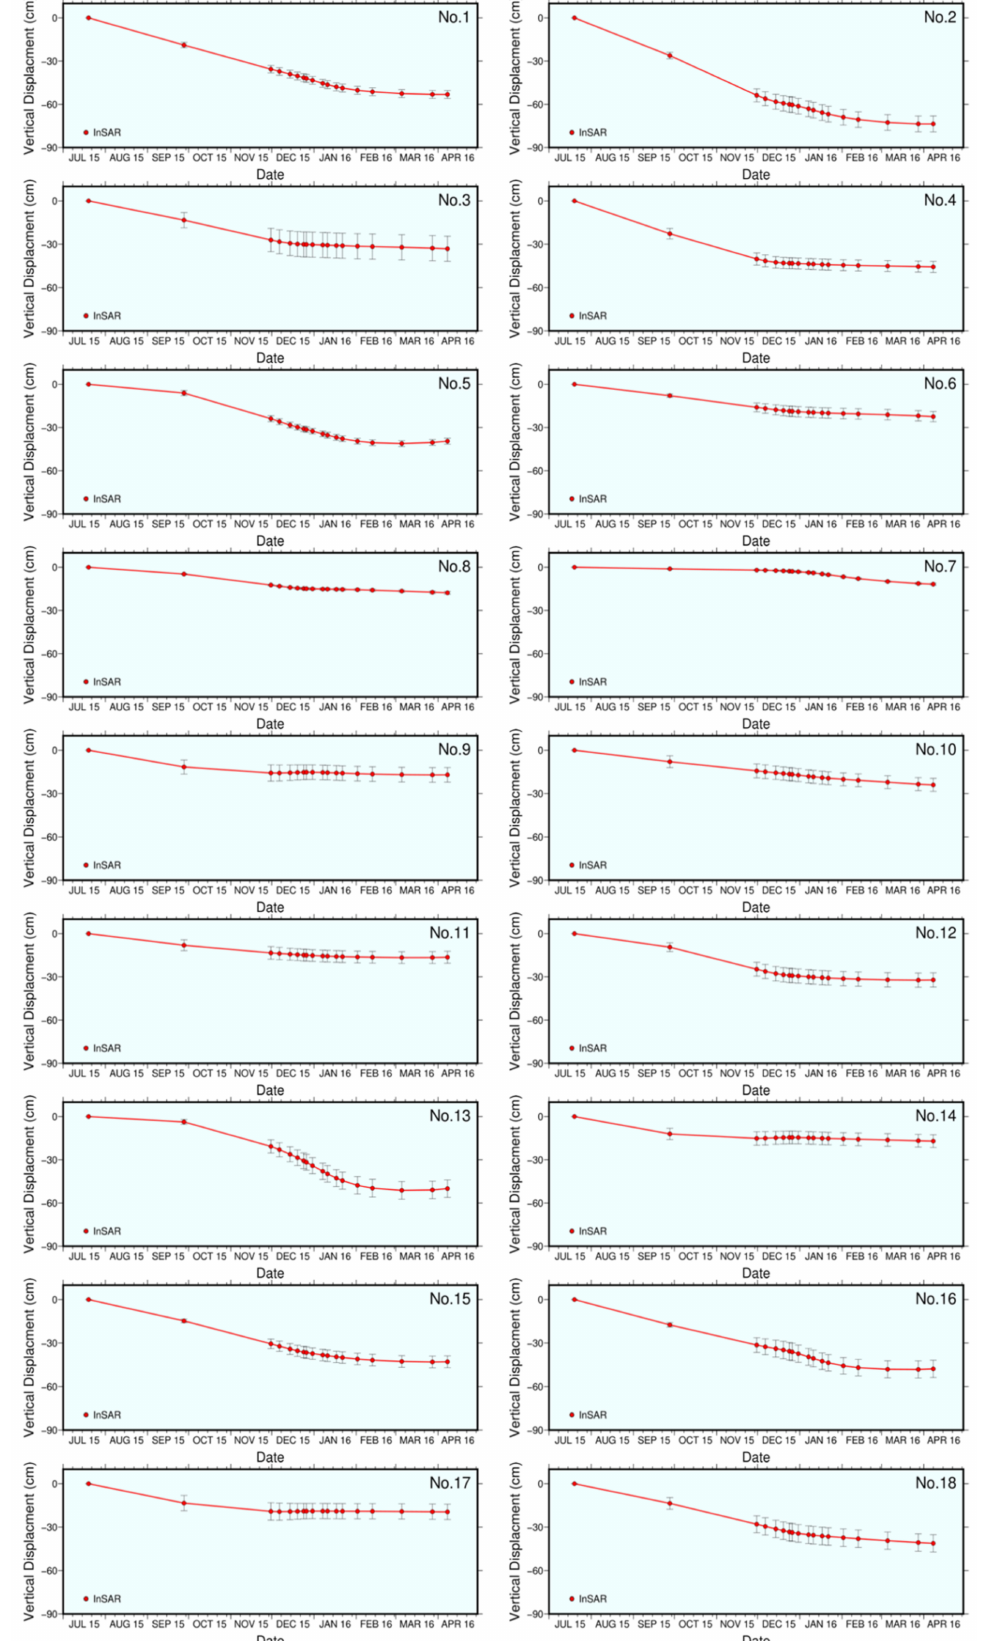
Figure A3. The subsidence time series of mining sites from No.1 to